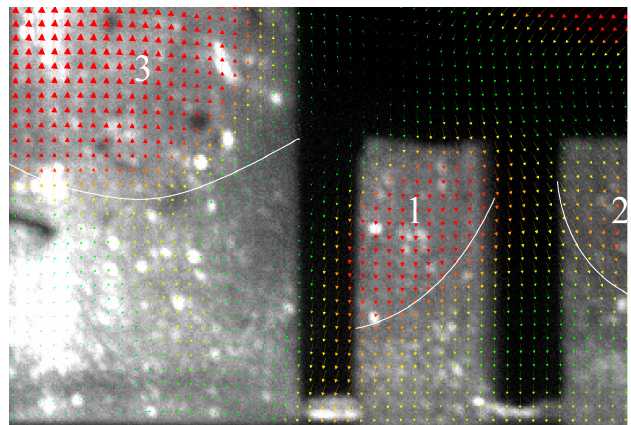
Figure 6. Vector diagram of soil displacement for MN-8 model.